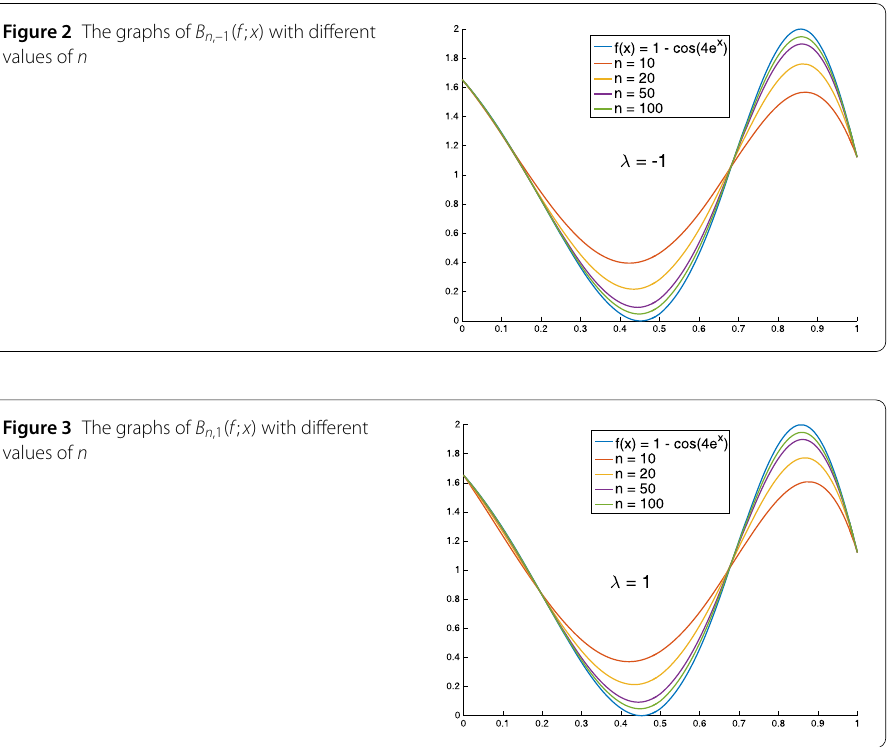
Figure 3 The graphs of B n ,1 ( f ; x ) with different values of n